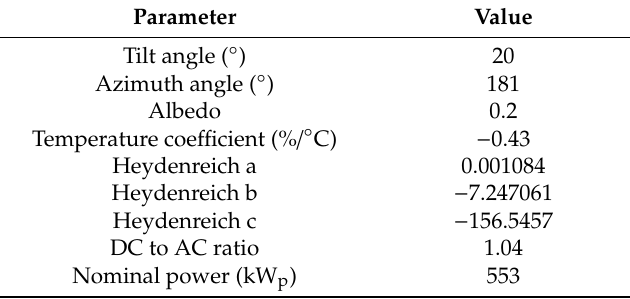
Table 1. Basic reported parameters from the PV plant located in south-west